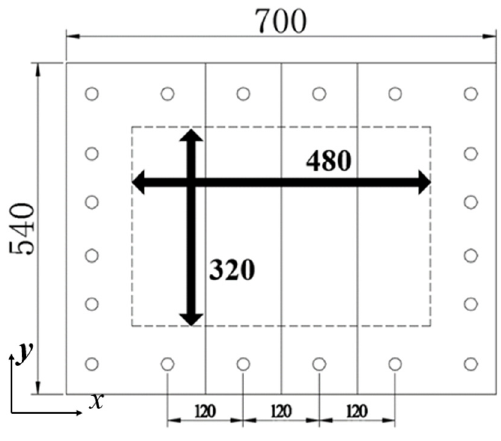
Figure 2. Schematic of stiffened plates.